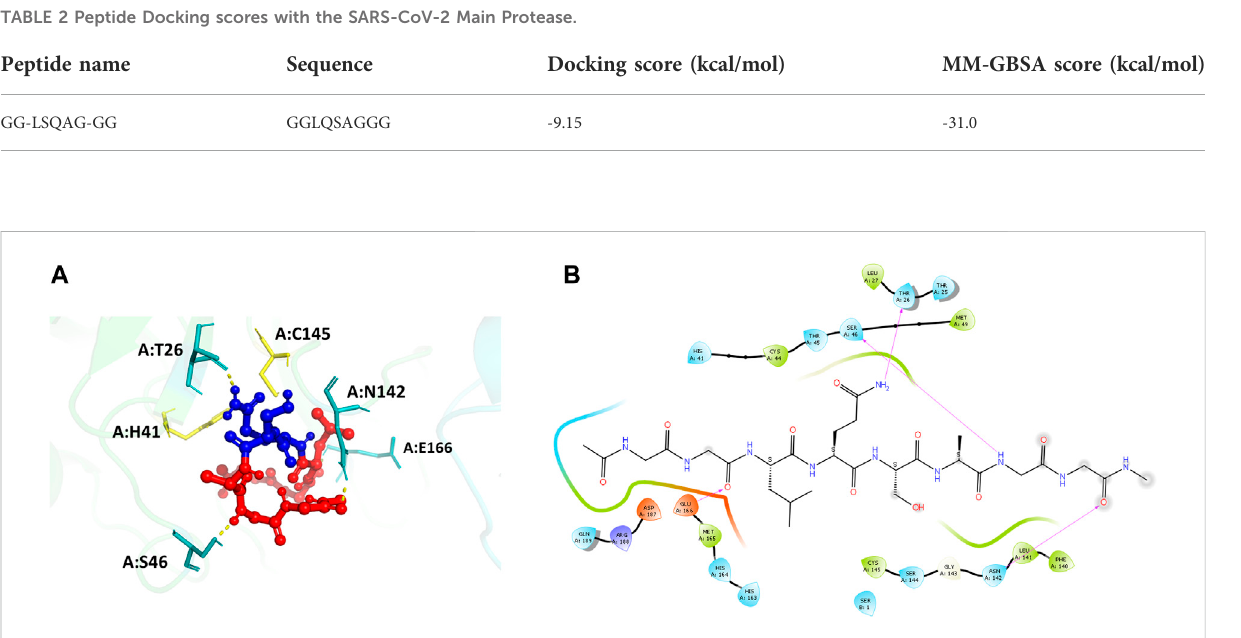
FIGURE 4 (A) Docking pose of the recognition peptide LQ ↓ SAG with two glycine caps (GG-LQSAG-GG) docked at the active site (in yellow) of the SARS- CoV-2 MPro with chain A ingreen and chainB incyan. The peptide GG-LQSAG-GG is shown as red balls and sticks with thecleavage sequence Q ↓ S shown in blue. The H-bond interactions are shown in yellow and the interacting residues in teal. (B) The ligand interaction diagram showing the docked pose of GG-LQSAG-GG and the residues forming a pocket around